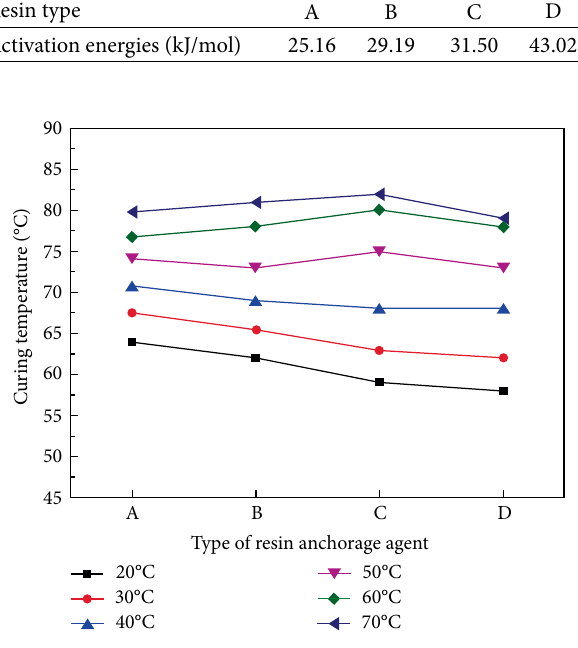
Figure 10: Peak curves of